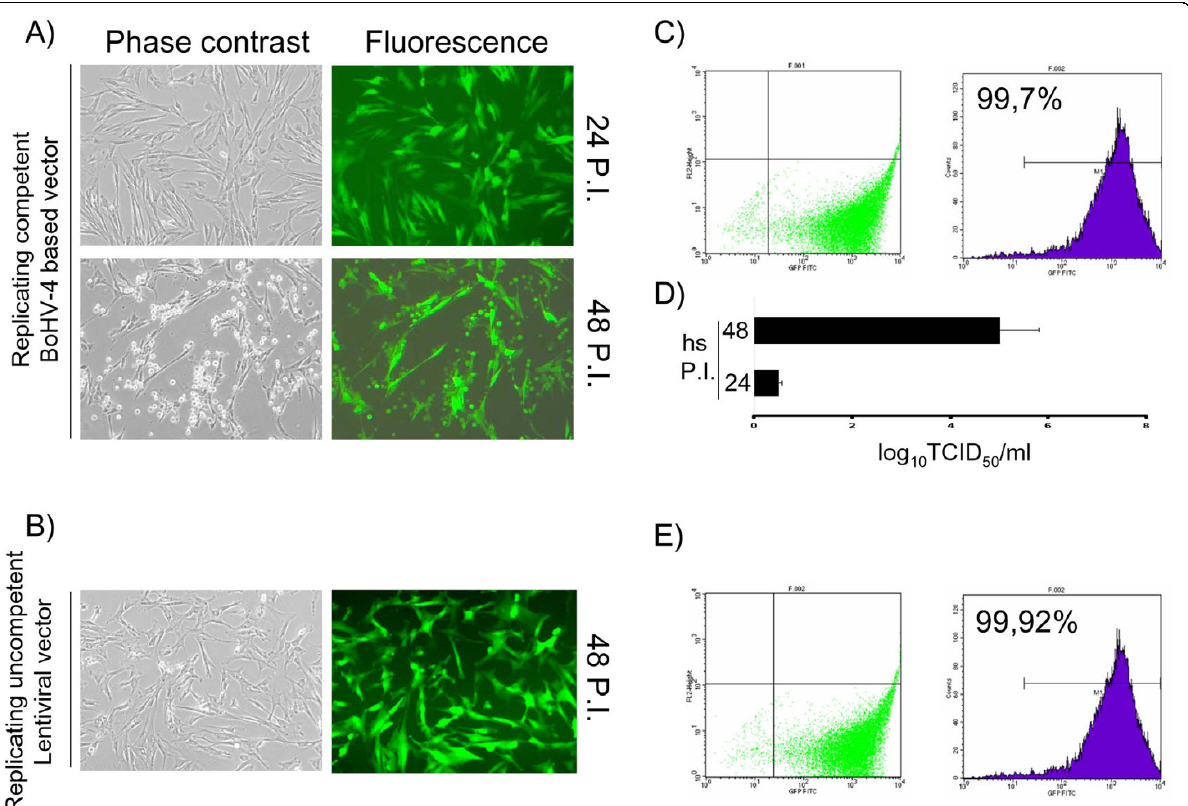
Figure 2 Viral transduction of EADSCs . Phase contrast and fluorescence representative images (20×) of BoHV-4-based vector transduced EADSCs at 24 and 48 h post infection (P.I.) (A), along with the transduction efficiency measured by flow cytometry (C) and the viral titer measured at 24 and 48 h post infection (hs P.I.) (D). In B, representative images of lentiviral vector transduced EADSCs at 24 h post infection and respective transduction efficiency measured by flow cytometry